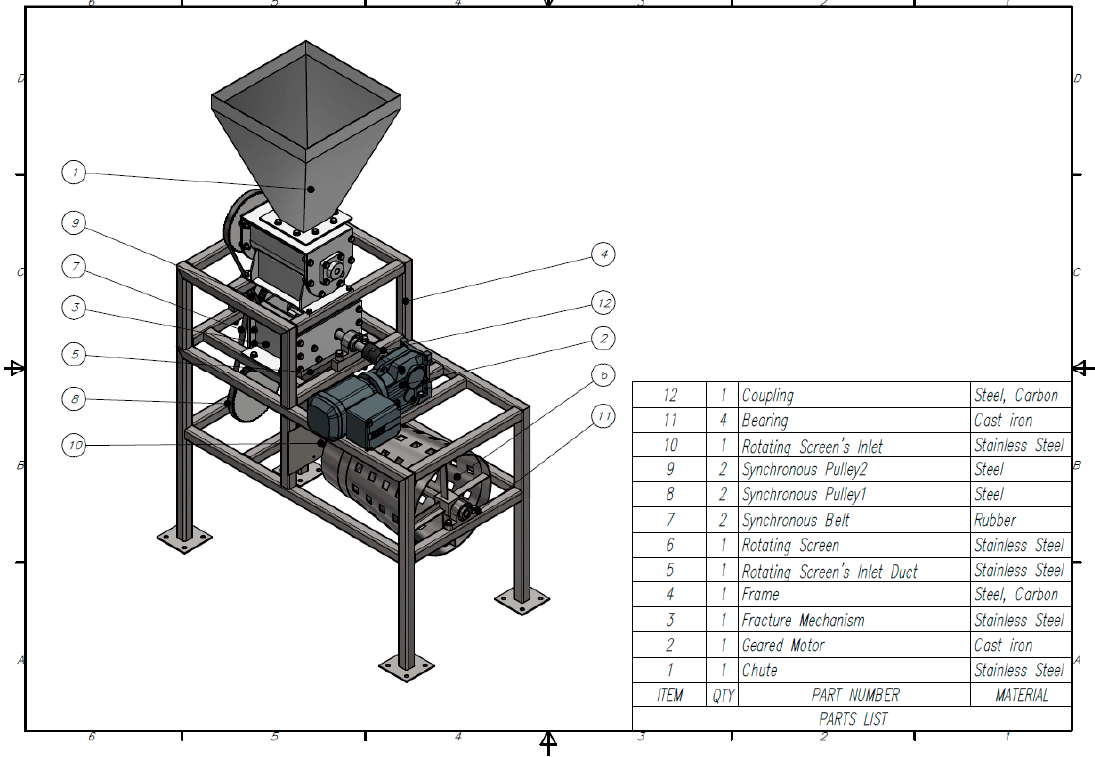
Figure 12. Assembly plan of the shell cracking machine and its elements.